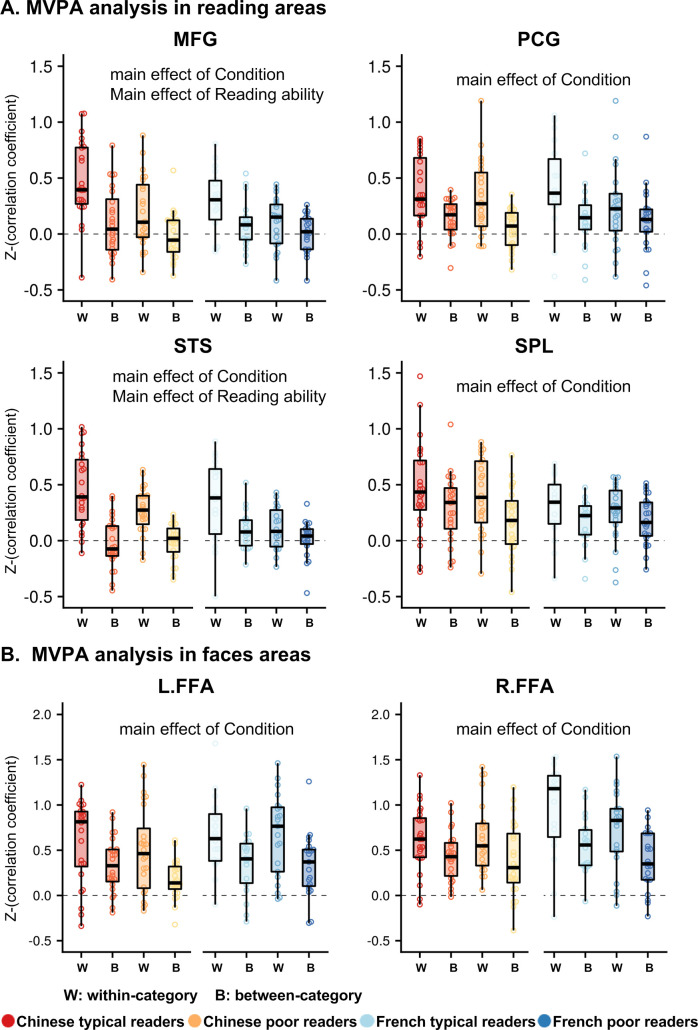
MVPA analyses.All these regions showed a main effect of condition, with higher correlation coefficients in within-category than between-category. Besides, the left MFG and STS showed a main effect of reading ability, with lower correlation coefficients across runs in poor readers than typical readers. Note that neither the interaction of condition × reading ability nor condition × reading ability × language reached significant in above regions.